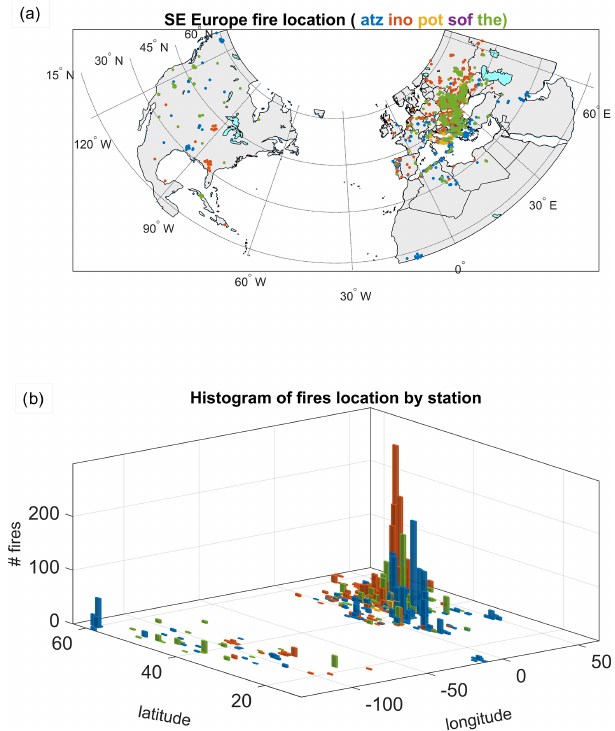
Figure 11. South-eastern European region formed by stations Athens (“atz”), Bucharest (“ino”), Potenza (“pot”), Sofia (“sof”), and Thessaloniki (“the”). (a) Location of the fires detected by each station. Note that due to overlap, some are not seen. (b) Histogram of the fires detected by each